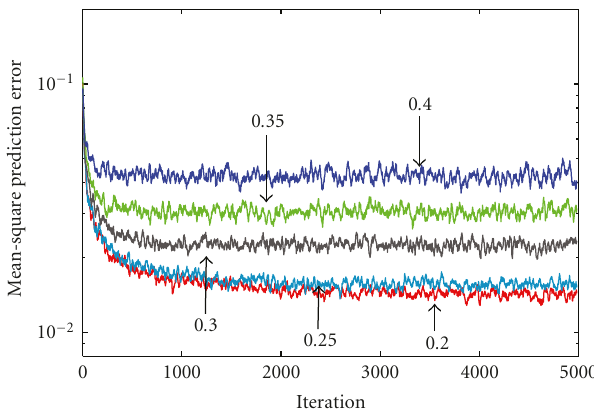
Figure 5: Learning curves for ν x varying from 0 . 20 to 0 . 40, obtained by averaging over 200 experiments.